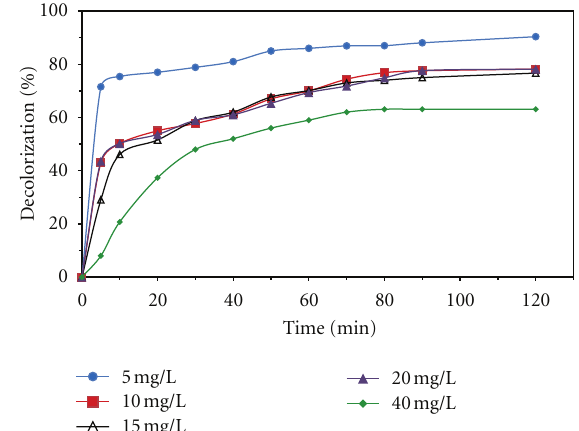
Figure 5: Decolorization percentage at various concentrations of MG at [Glucose] 0 = 1 g/L, [enzyme] 0 = 1000 U/L, [Fe 2+ ] 0 = 10 mM, and T = 30 ◦ C.